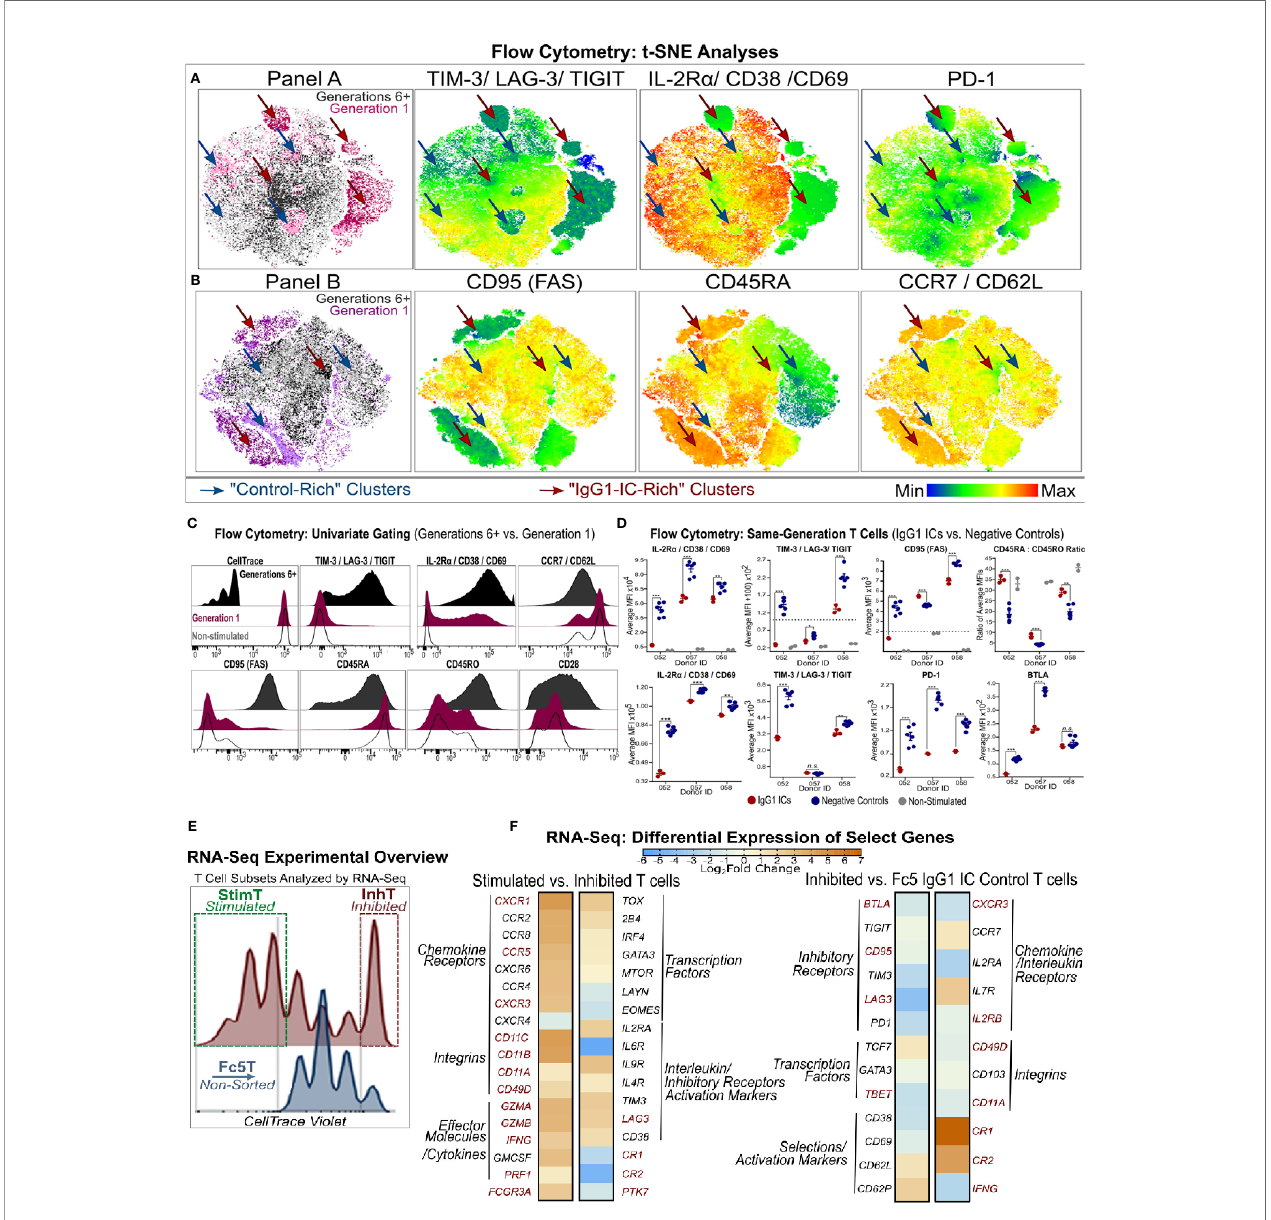
FIGURE 4 | Phenotypic Analysis of Inhibited and Stimulated T cell subsets Following Incubation with IgG1-ICs (A, B) t-distributed Stochastic Neighbor Embedding (tSNE) analysis of multi-color fl ow cytometry panels of activated naïve T cells incubated with IgG1-ICs or controls (Fc5 IgG1-ICs, monomeric IgG1, or TNP-BSA only). Naïve T cells were sampled equally across all controls and donors (N = 3 donors; 2 naïve CD8+ and 1 naïve CD4+). Red and blue arrows are visual aids pointing to “ IgG1-IC-rich ” or “ control-rich ” clusters, respectively. Gen1 and Gen6+ populations represent T cells that have not divided or divided at least 5 times, respectively. Gen1 T cells from samples incubated with or without IgG1-ICs are shown in dark and light pink/purple (Panel A/B), respectively. Gen6+ T cells from samples incubated with or without IgG1-ICs are dark and light grey, respectively. Heat-map t-SNE plots are shown for (i) TIGIT, TIM-3, and LAG-3 combination (i.e. TIGIT/ TIM3/LAG3 lump gate) (ii) CD25, CD38, and CD69 (i.e. CD25/CD38/CD69 lump gate) and (iii) PD-1 stain. (iv) CD95 (v) CD45RA and (vi) CCR7 and CD62L (i.e. CCR7/CD62L lump gate). Staining for other markers and/or non-stimulated naïve T cells is shown in Figure S8 . (C) Univariate plots for select markers from (A, B) are shown. The black and fuchsia histograms represent Gen6+ and Gen1 T cells regardless of treatment (IgG1-ICs and controls). Un fi lled histograms pertain to cultured, non-stimulated T cells. (D) Average MFI (median fl uorescence intensity) is shown speci fi cally for Gen1 (top panels) and Gen6+ (bottom panels) T cells incubated either with IgG1-ICs (red) or controls (blue). Error bars represent the standard error of the mean (SEM). Asterisks *, **, and *** indicate p-values < 0.05, p-values < 0.01, and p-values < 0.0001, respectively. Values below the dashed lines are negative (common, unavoidable consequence of compensation) (E) Schematic overview of T cell populations analyzed by RNA-Seq (activated naïve CD8+ T cells incubated with either IgG1-ICs or Fc5 IgG1-ICs). IgG1 IC-treated T cells were sorted for cells stimulated by IgG1-ICs (StimT) and those inhibited by IgG1-ICs (InhT). Fc5 IgG1-IC-treated T cells (Fc5T) are not sorted. (F) Differential expression of select genes across StimT, InhT, and Fc5T. Genes are differentially expressed if the adjusted p-value < 0.05 and fold change (FC) ≥ 1.5 in either direction. Select DEGs mentioned in-text are in red. Other genes discussed in-text are shown in Table S4